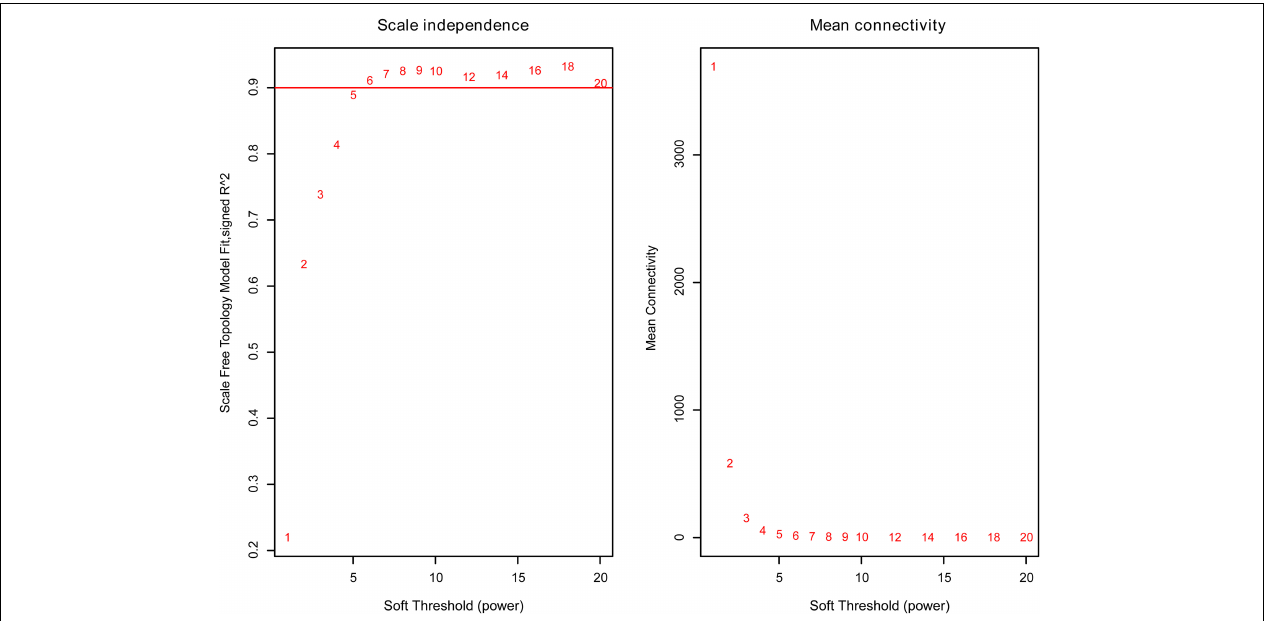
FIGURE 2 | The relationship between soft threshold (power) and network properties. Left panel: The relationship between soft-threshold (power) and scale-free topology. Right panel: The relationship between soft threshold (power) and mean connectivity. When the soft threshold (power) was six, the scale-free topology ( R 2 ) was 0.91 and mean connectivity became stable. Therefore, we set the soft threshold (power) to be